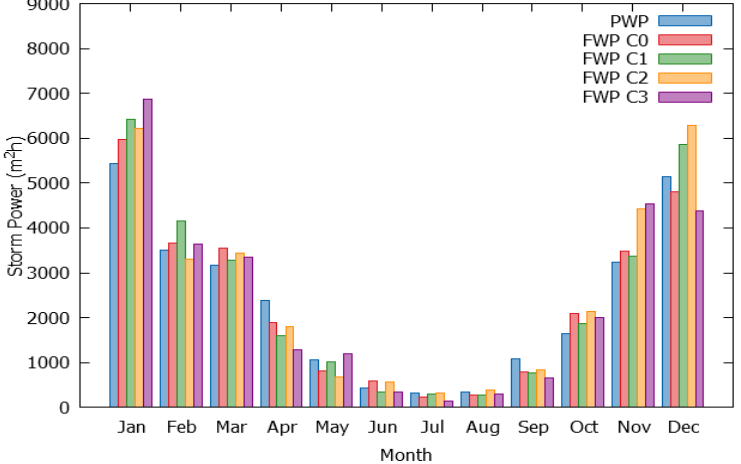
Figure 10. Comparison of present (PWP) and future (FWP-C0–C3) storm power index ( S pi ) at Pembroke.